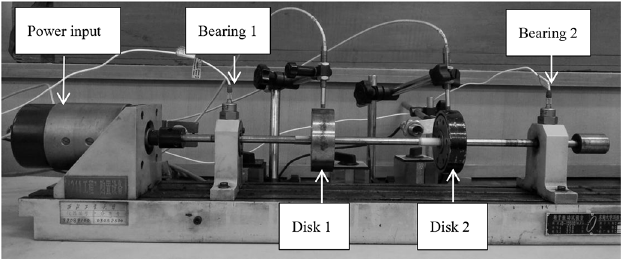
Fig. 1. The fl exible rotor system.